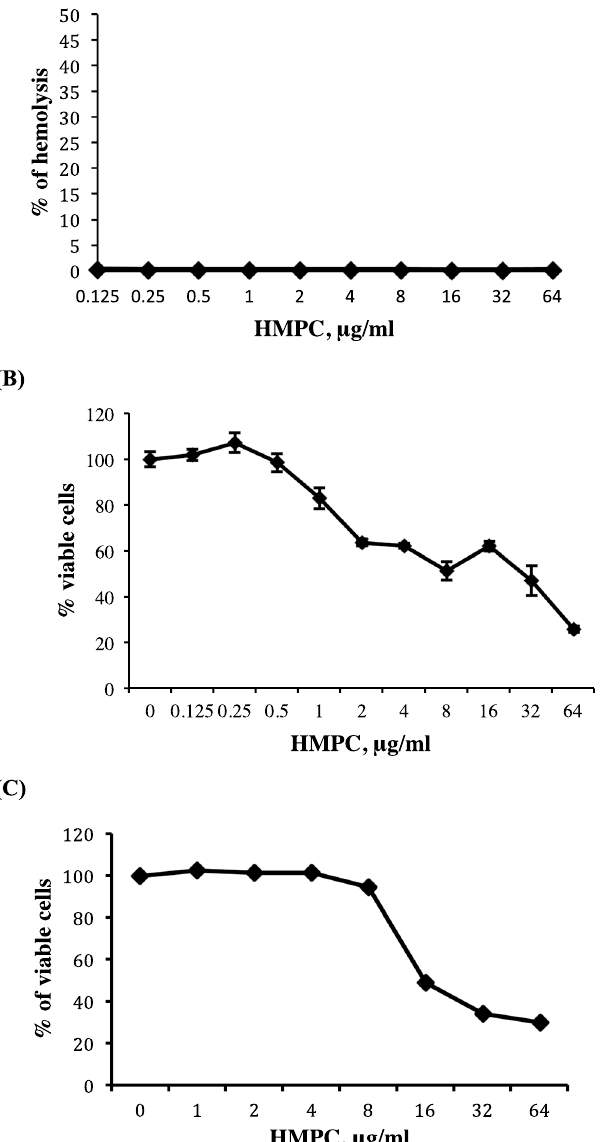
Figure 6. Mammalian cell toxicity assays. ( A ) HMPC hemolysis assay. Red blood cells were diluted to 2% with PBS and then incubated with HMPC over the concentration range 0.125 − 64 μ g/ml. ( B ) Cytotoxicity of HMPC towards HKC-8 cells. HKC-8 cells were treated with increasing concentrations of HMPC for 24 hours before assessing viability using a WST-1 assay. ( C ) Cytotoxicity of HMPC towards HepG2 cells. HepG2 cells were treated with increasing concentrations of HMPC for 24 hours before assessing viability using a WST-1 assay. All experiments were repeated twice in triplicate and data show the mean + / − standard